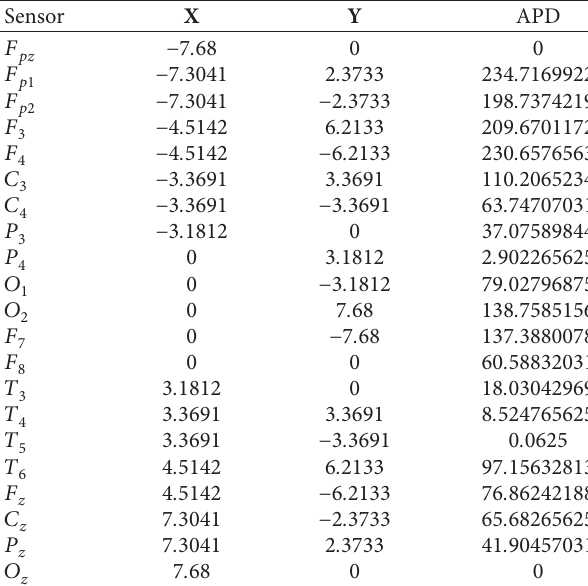
Table 6: Reordering the average potential difference (APD) at the sensor for a patient A at time t � 3 [30].